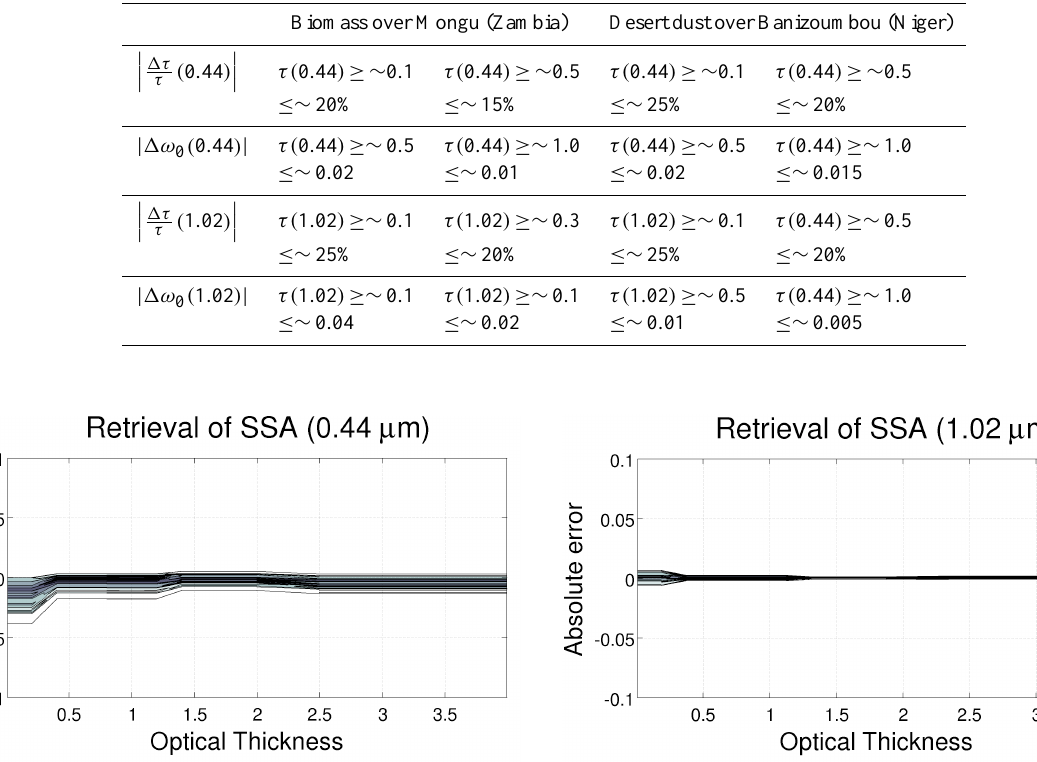
Table 7. The summary of the sensitivity tests for aerosol retrievals from simulations mimicking POLDER observations over Mongu (Zambia) and over Banizoumbou (Niger) with the added random noise at the level of standard deviation σ = 1% for total radiances and σ = 0 . 5% for the degree of linear polarization.